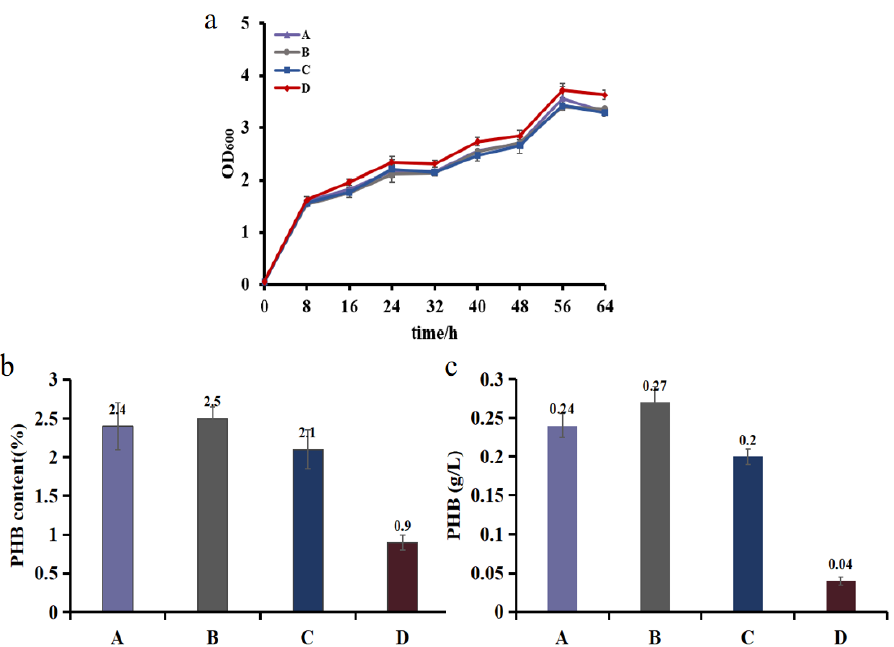
Figure 6. PHB fermentation in various engineered E. coli strains. ( a ) Growth of strains. ( b ) PHB content and ( c ) concentration at the end of fermentation. The experiments were performed in duplicate, and error bars indicate standard deviations (SD).